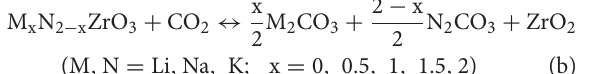
Figure 6 demonstrated the calculated relationships among the Gibbs free energy change, CO 2 pressure and temperature for CO 2 capture reactions by Na 2 − x M x ZrO 3 (M = Li, K, x = 0.0, 0.5, 1.0, 1.5, 2.0). Figure 7 showed the dependence of T t and CO 2 capture capacity on Li/K doping molar percentage in Na x M 2 − x ZrO 3 (M = Li, K). One can see from Figure 6 that when Na 2 ZrO 3 is